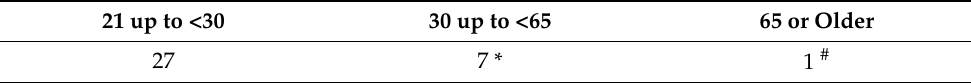
Table 3. Dataset of human subjects breakdown by their ages. 21 up to <30